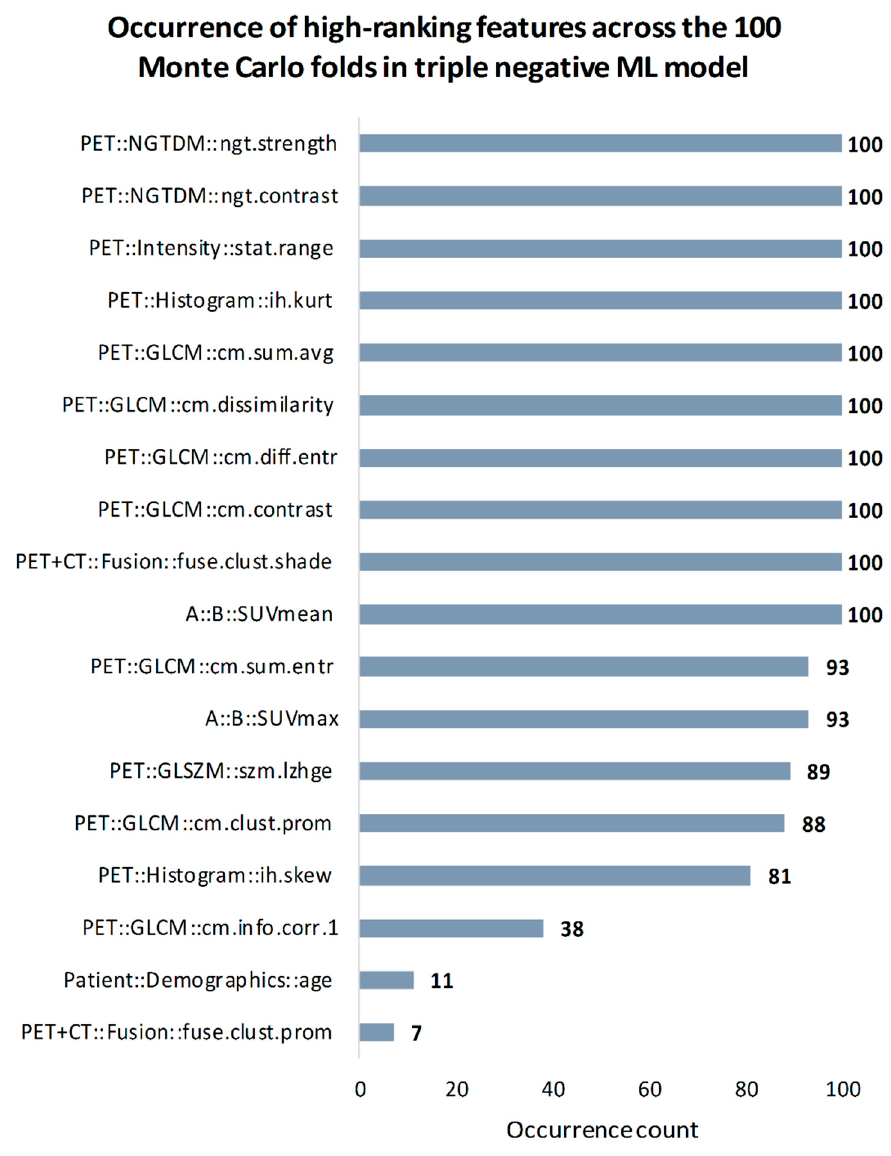
Figure 6. Occurrence of high-ranking features across the 100 Monte Carlo folds in triple negative predictive model. NGTDM = neighborhood grey tone difference matrix; GLCM = gray level co-occurrence matrix; GLSZM = gray level size zone matrix; SUV max = maximum standard uptake value; SUV mean = mean standard uptake value; kurt = kurtosis; sum.avg = sum average; diff.entr = difference entropy; clust.shade = cluster shade; sum.entr = sum entropy; lzhge = large zone high grey level emphasis; clust.prom = cluster prominence; skew = skewness; info.corr.1 = information correlation 1.